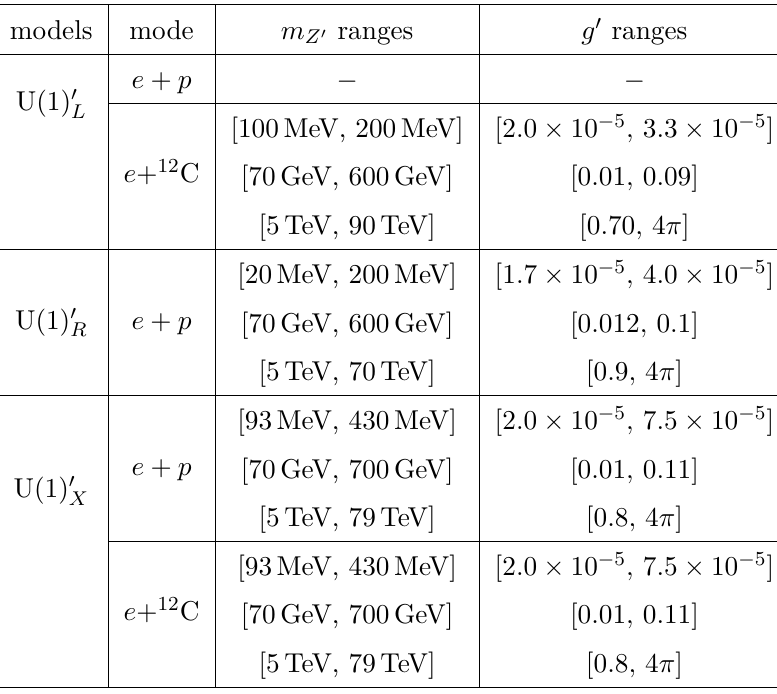
Table 4 . Ranges of m Z 0 and g 0 where P2 will be able to improve current limits for chiral U(1) 0 models. This table is a summary of figure 2. The columns of U(1) 0 because P2 does not have sensitivity beyond existing APV